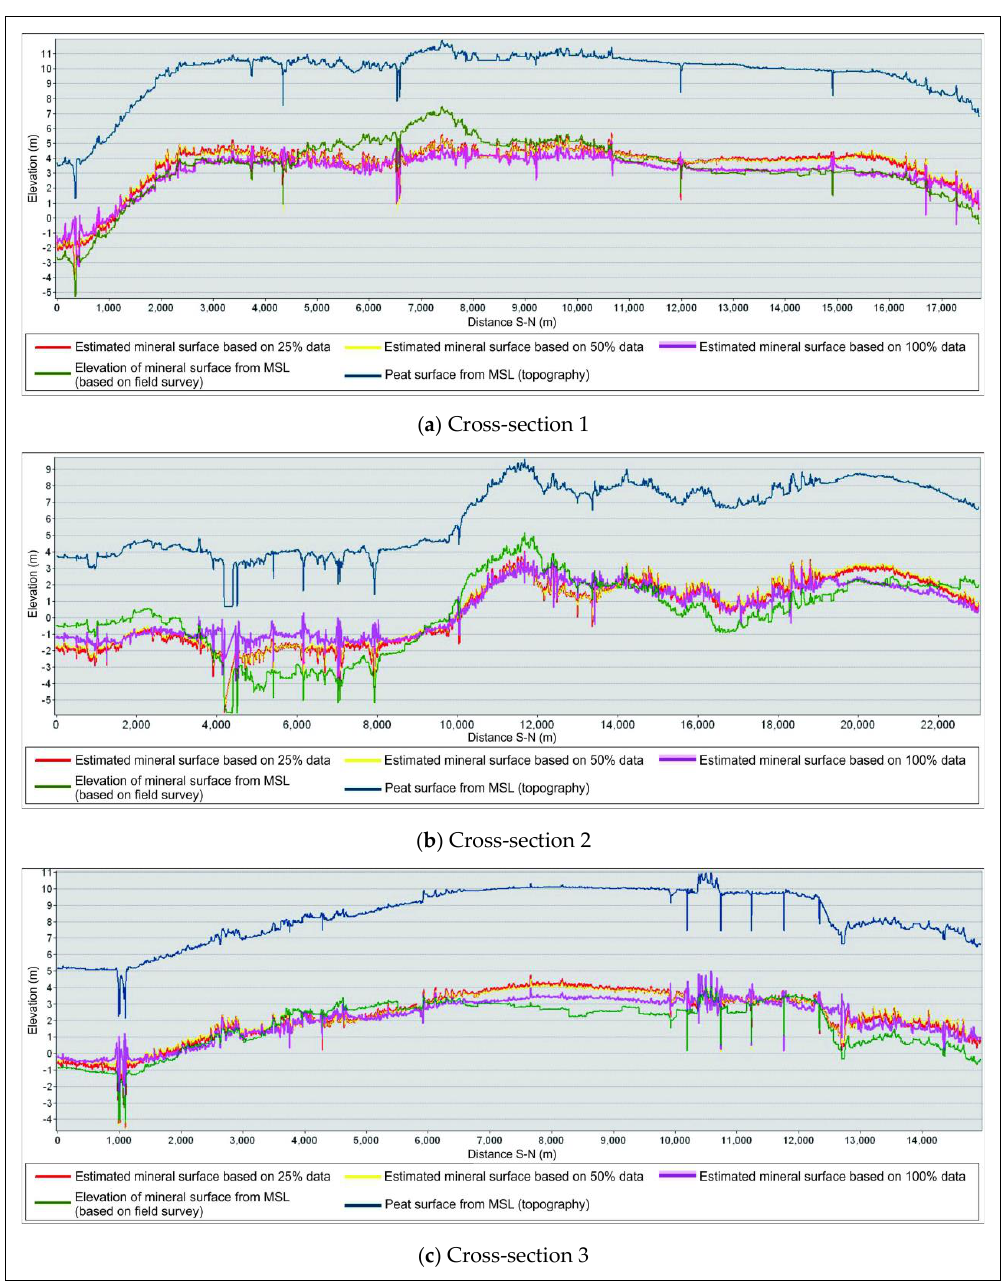
Figure A2. Cross-section view of Cross-section 1, Cross-section 2, and Cross-section 3 lines of mineral soil elevation based on 25%, 50%, and 100% of the data, which are overlaid on the peat surface topography and the real mineral soil elevation.